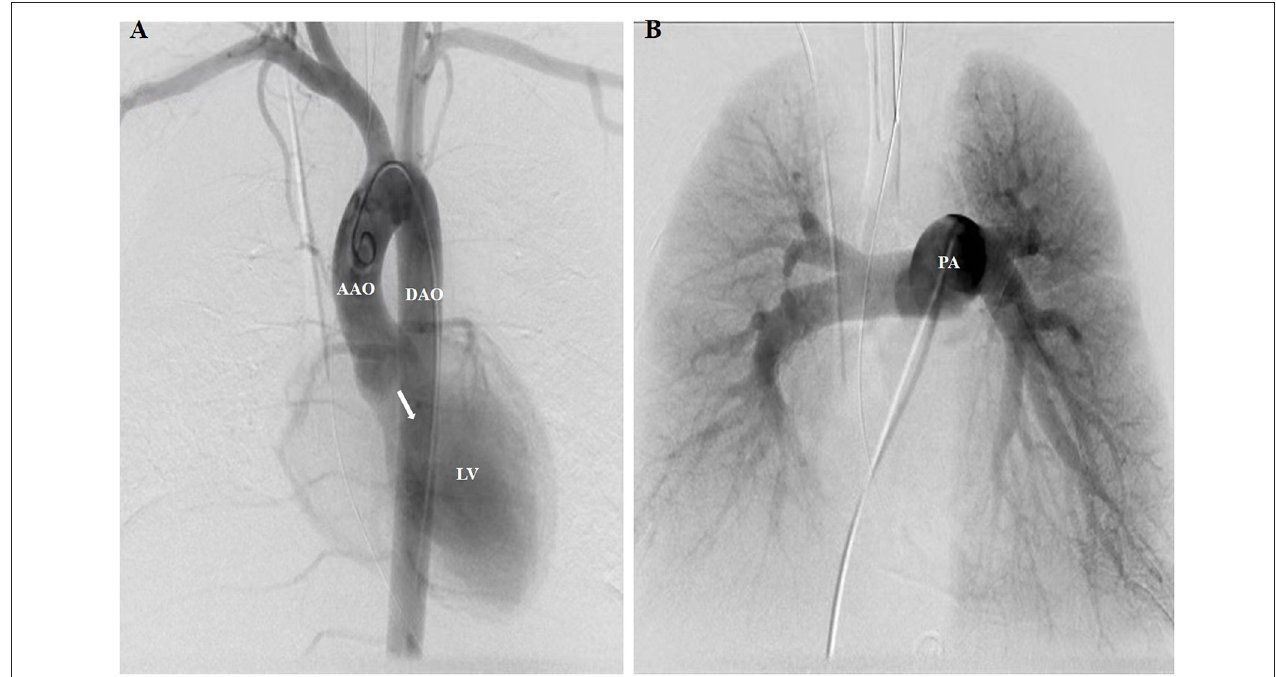
FIGURE 2 | A pigtail catheter was advanced for the aortic and pulmonary angiogram. (A) Aortic angiogram showed severe diastolic retrograde flow (white arrow) from the AAO to the LV. No enlarged or ruptured bronchial arteries, which may be responsible for hemoptysis, were found to originate from the supra-aortic branches or DAO. (B) Pulmonary angiogram showed no pulmonary vascular abnormalities responsible for hemoptysis, such as post-traumatic PA pseudoaneurysms and pulmonary arteriovenous malformations. AAO, ascending aorta; DAO, descending aorta; LV, left ventricle; PA, pulmonary